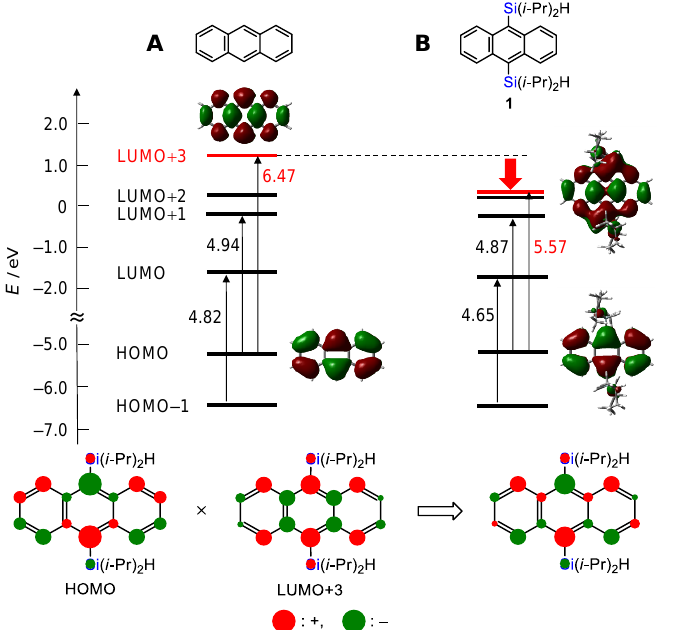
Figure 6. Comparison of the HOMO-to-LUMO+3 transitions of 1 ( B ) and anthracene ( A ) calculated at the B3LYP/6-31G(d) level. The product of the HOMO and LUMO+3 of 1 is shown at the bottom .